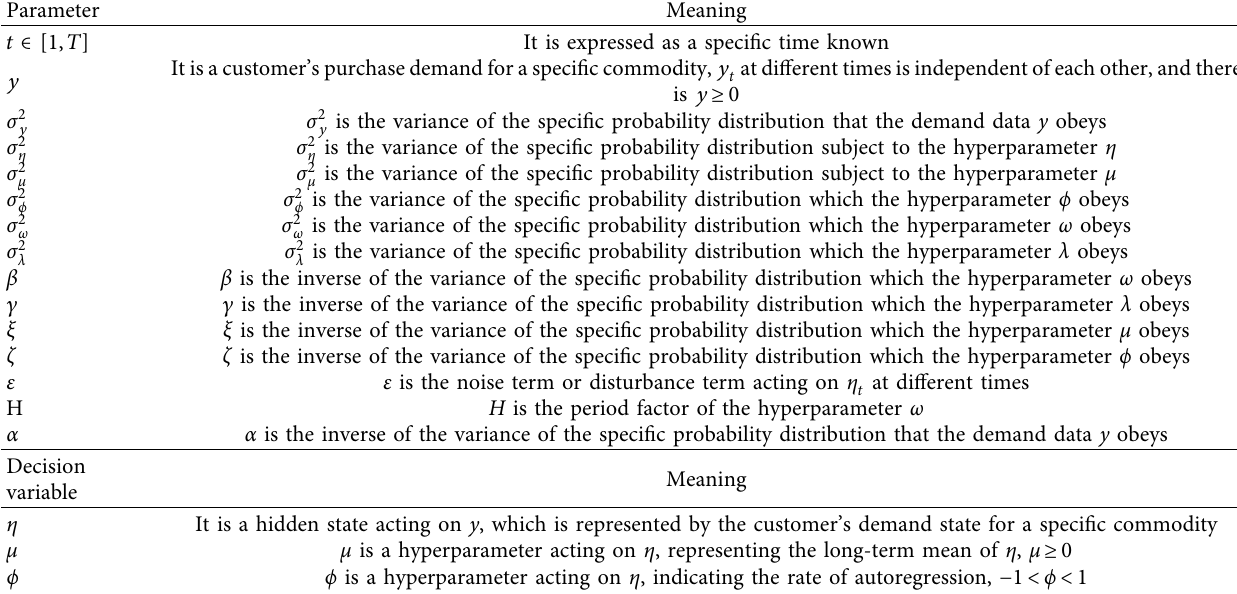
Table 2: Description of main parameters and decision